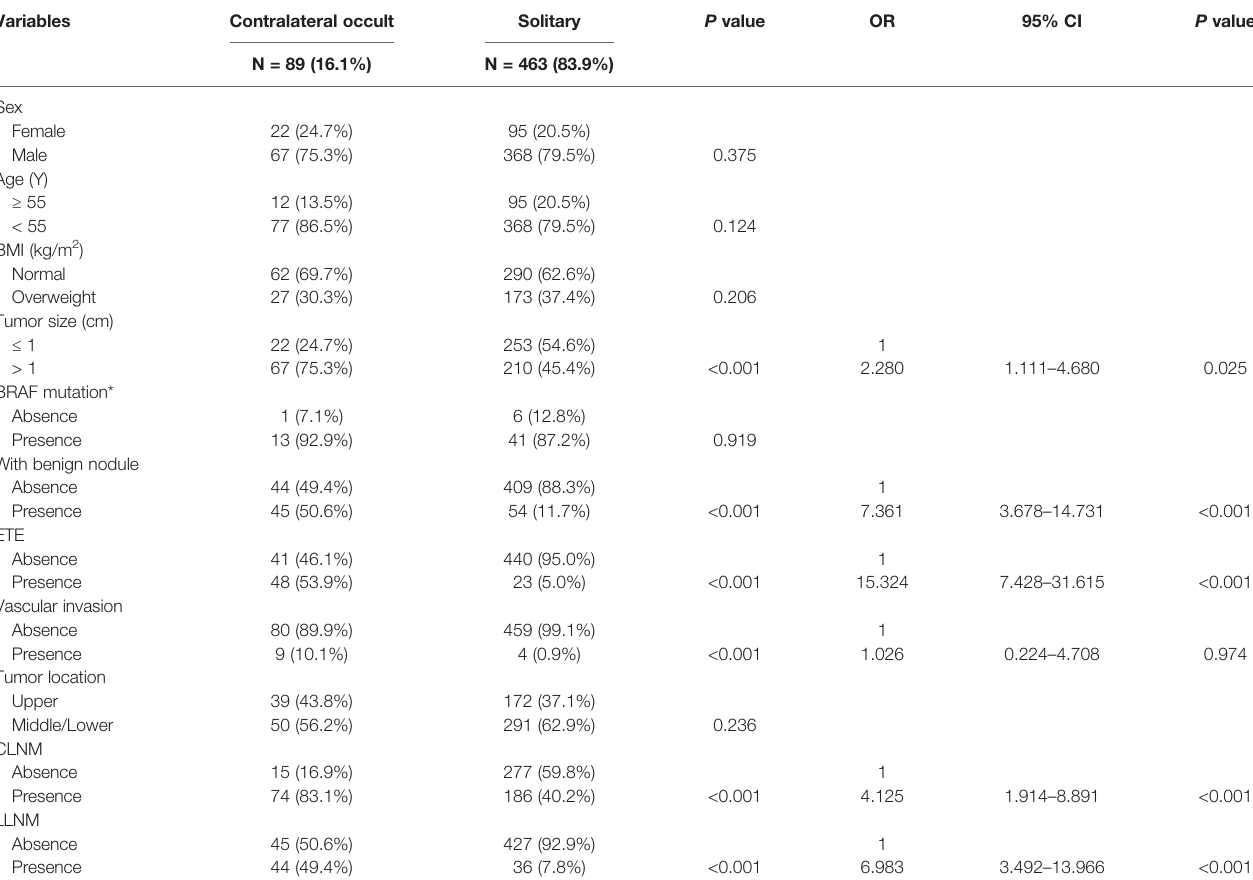
TABLE 2 | Associations between clinicopathological characteristics and contralateral occult carcinoma in PTC patients.